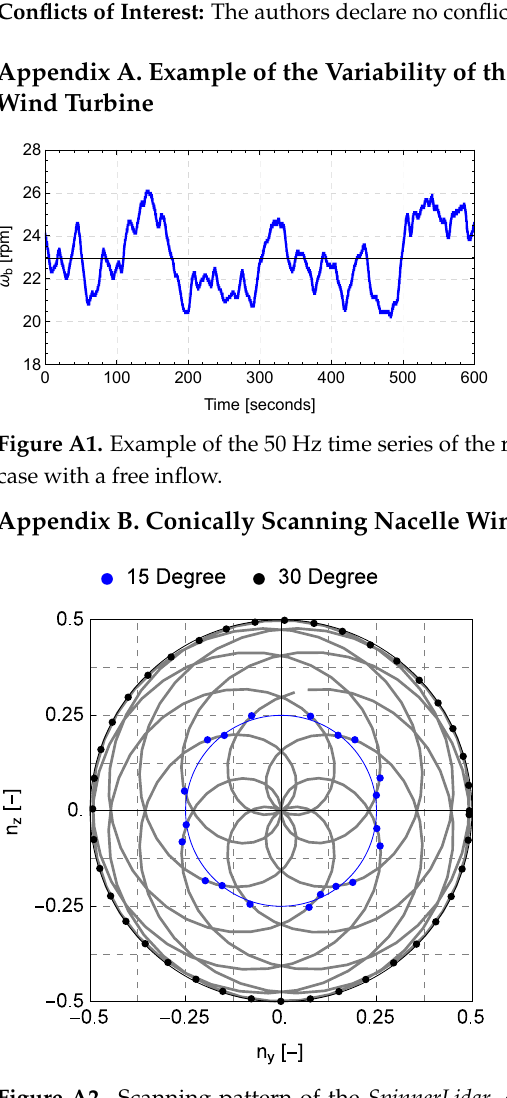
Figure A2. Scanning pattern of the SpinnerLidar , depicted in grey, and points selected from the scanning pattern in order to reproduce the measurements of a conically scanning wind lidar with an opening angle of either 15 ◦ or 30 ◦ , depicted in blue and black,